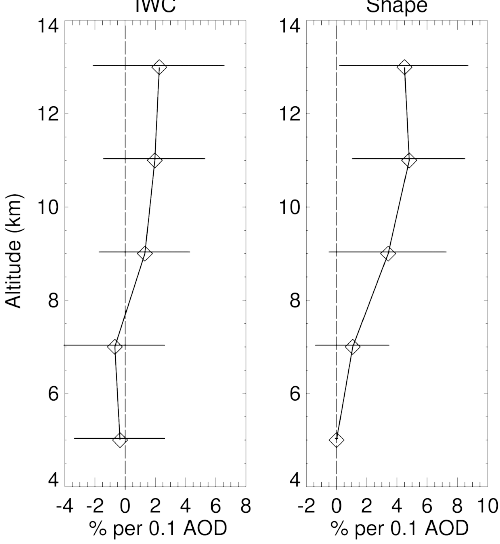
Figure 12. Means of PDFs of IWCreg and IWCshape derivatives over ocean and land, excluding derivatives greater than 100% per 0.1 AOD. Mean 95% confidence limits, given by the horizontal lines, indicate that IWCshape means are positive to the 2 σ level for the 11–15km altitude